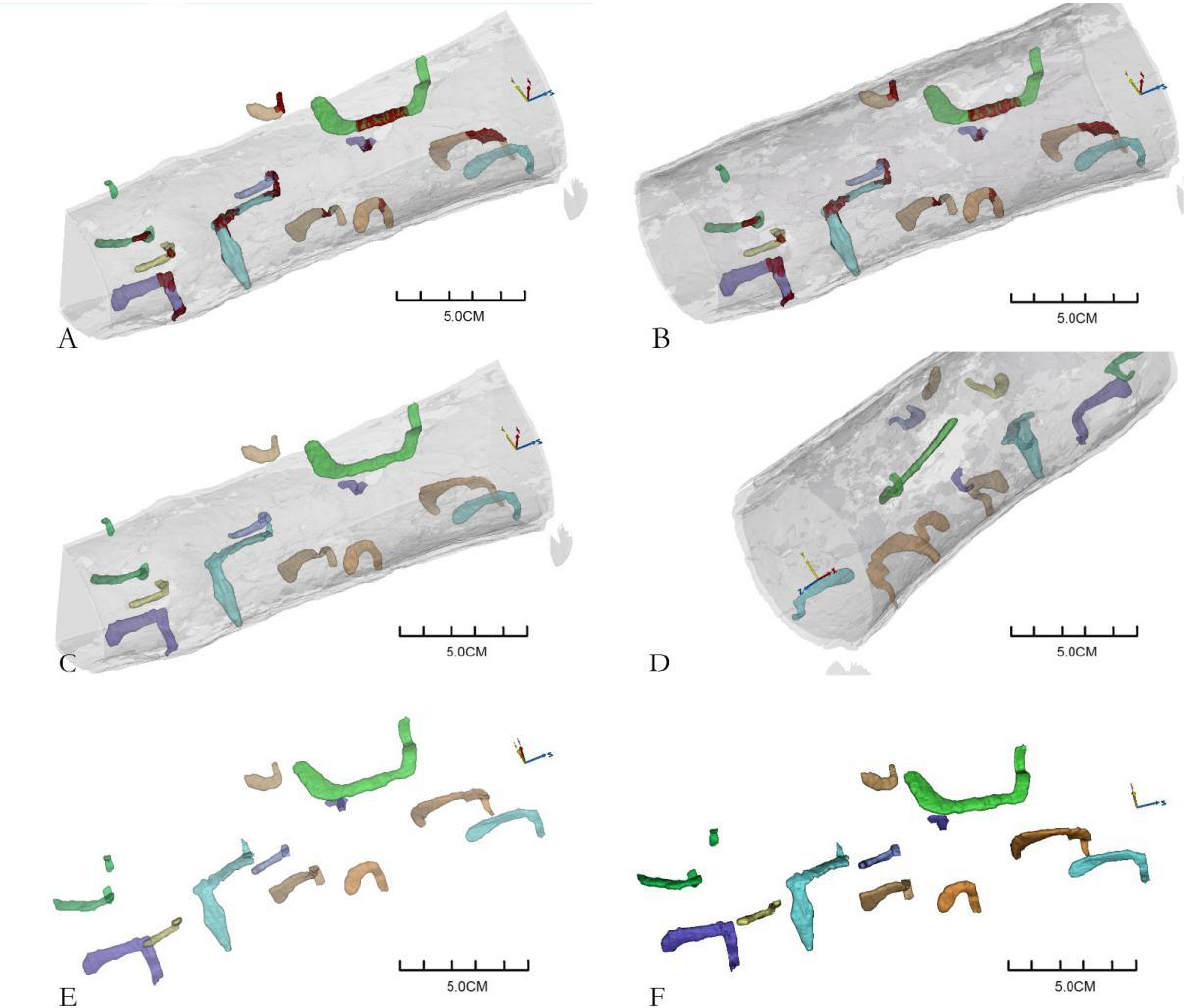
Figure 2. Three-dimensional reconstruction of Monochamus alternatus gallery structures (( A – D ) are different perspectives of the three-dimensional reconstruction galleries in the same wood segment; ( E , F ) are two perspectives of segmented galleries. Different colors represent different galleries, except that the brown indicates the blocked part of the galleries.).